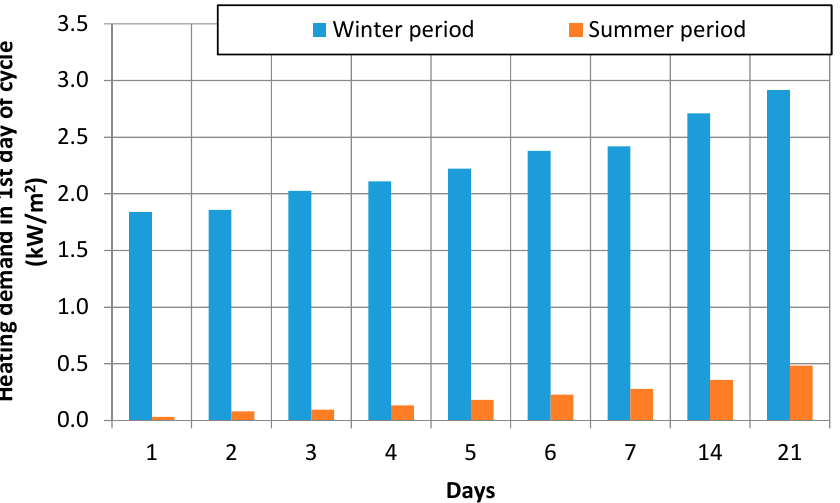
Figure 7. Energy demand for heating 1 m 2 of the building floor for the technological interruptions of 1, 2, 3, 4, 5, 6, 7, 14, and 21 days in the winter and summer periods.